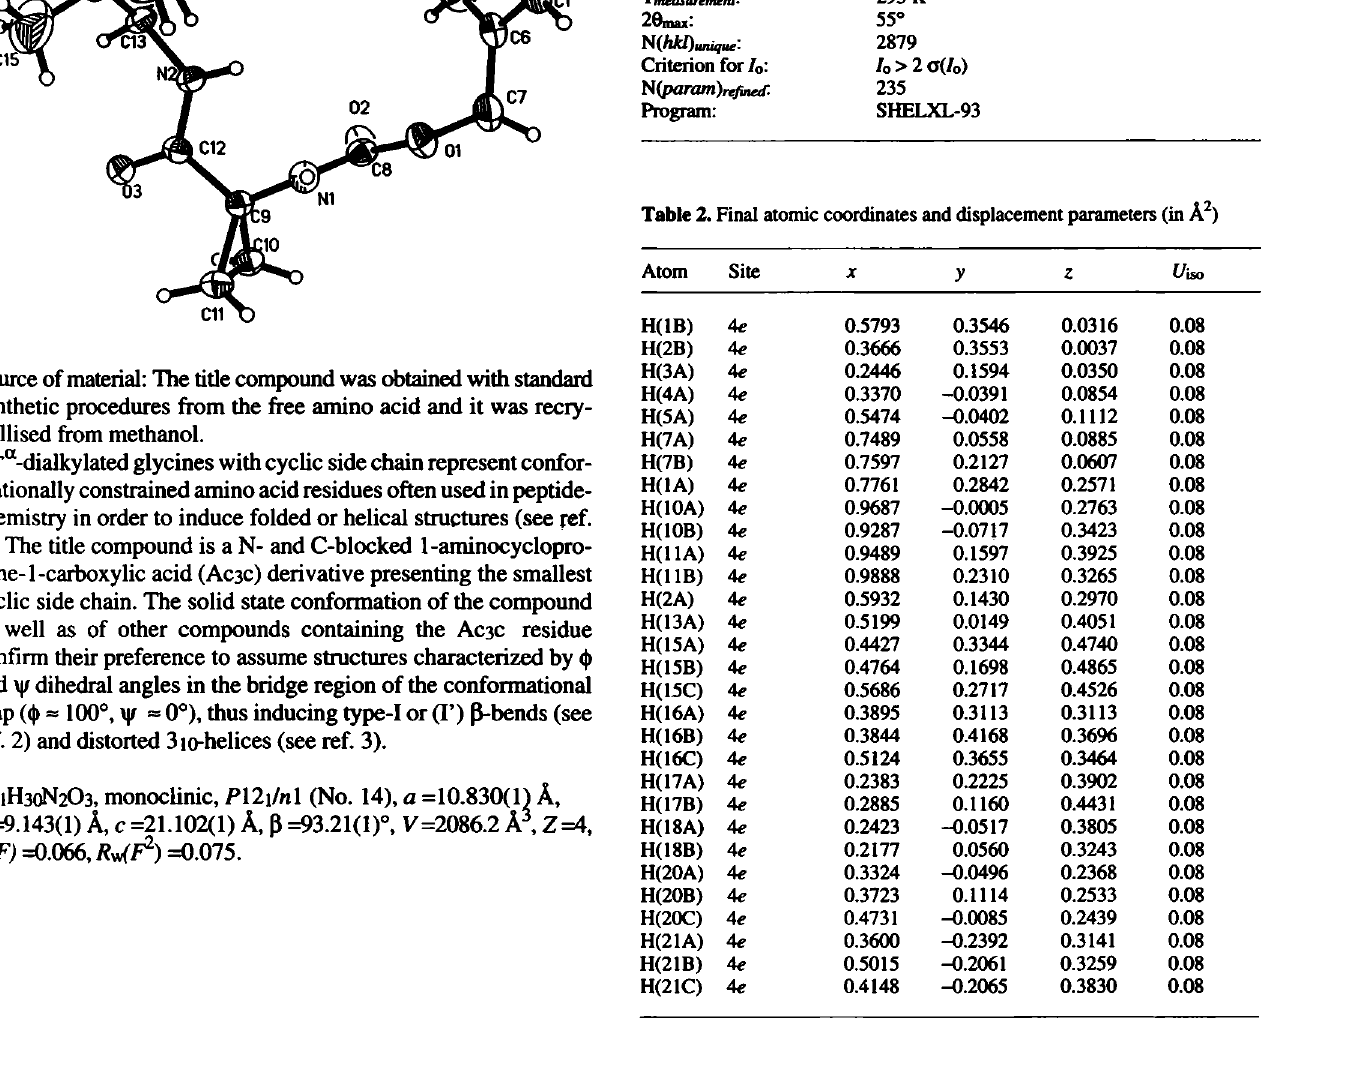
Table 1. Parameters used for the X-ray data collection